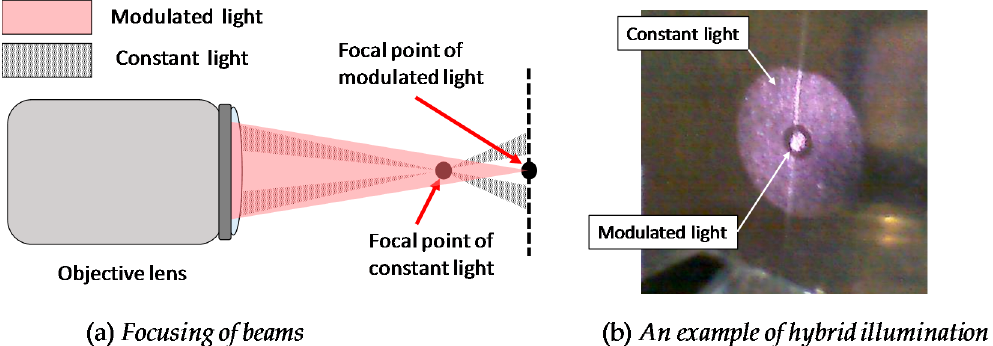
Figure 3. ( a ) Displacement between focal points of modulated light and constant light; and ( b ) an example of hybrid illumination.